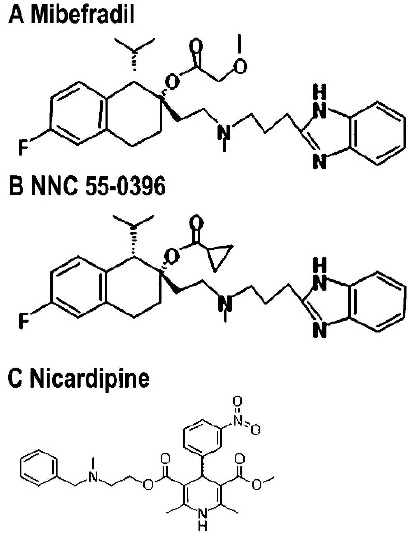
Figure 1 - Chemical structure of calcium channel blockers.